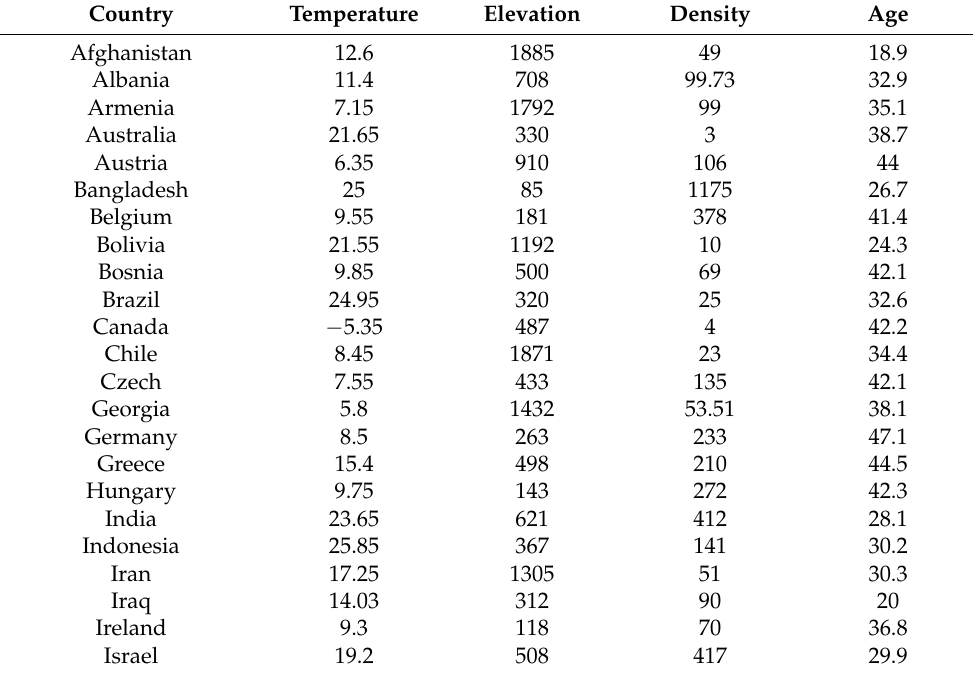
Table 7. Environmental variables for 51 countries, mean annual temperature, mean elevation, population density per square kilometer, and median age. P K-S is the p -value along the Kolmogorov– Smirnov test for